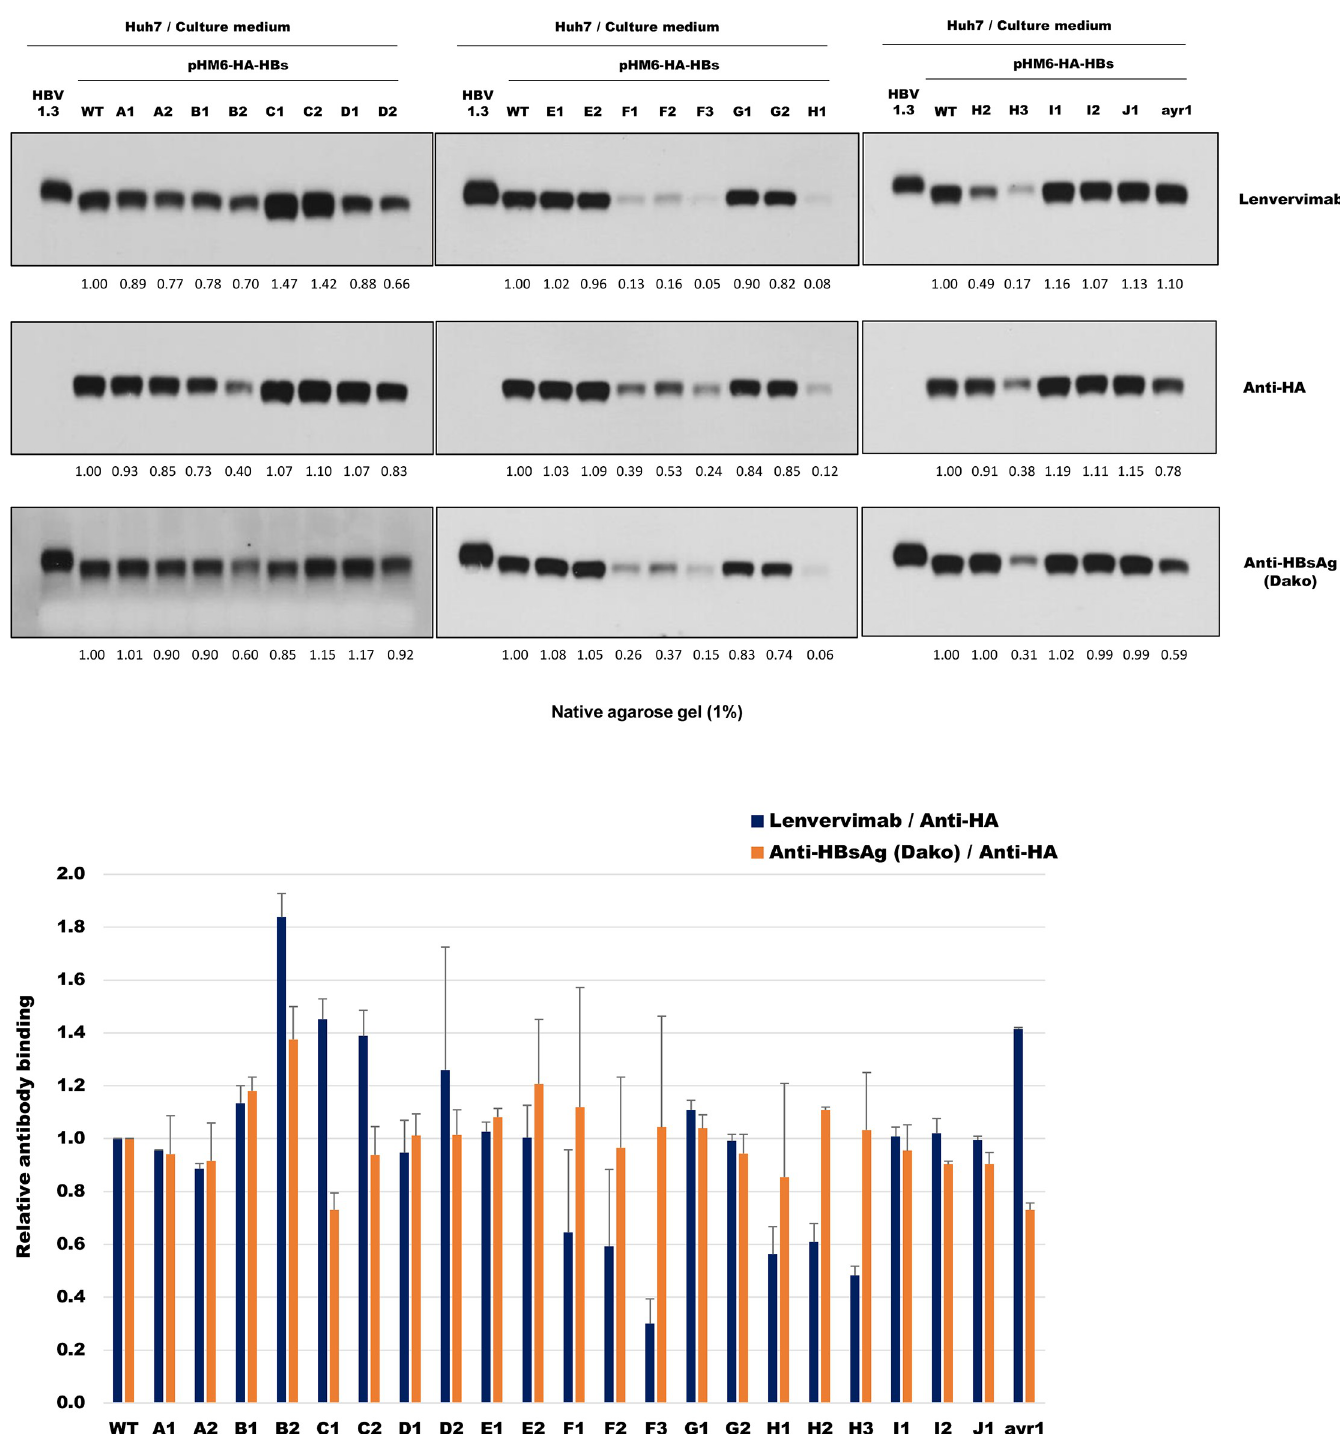
Fig 3. Lenvervimab binds the S antigens of all viral genotypes. (A) Aliquots of culture supernatant from transfection of various genotype S clones pHM6-HA-HBs were separated by nondenaturing agarose gels, capillary-transferred to a nitrocellulose membrane and probed with either Lenvervimab (upper), anti-HA (middle) or Dako’s polyclonal anti-HBsAg (lower) antibodies. HBV1.3 was included as a control. Indicated below the image is the quantified signal intensity of each clone relative to that of a genotype D clone (ayw), referred here as wild type (WT). The image is a representative of two independent experiments. (B) Indicated as bars are signals of the Lenvervimab (in dark) and the Dako’s anti-HBsAg antibody (in yellow) after normalization with anti-HA antibody signal. Average and standard errors of duplicate immunoblot analyses are shown.